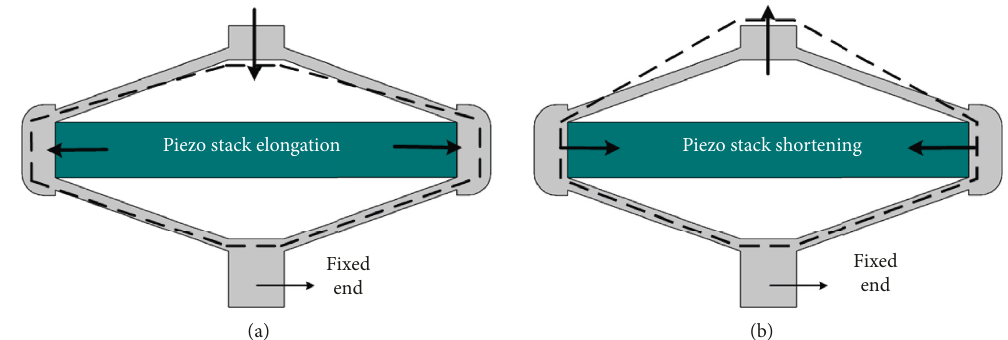
Figure 3: Schematics of the RPA: (a) pull driving mode; (b) push driving mode.